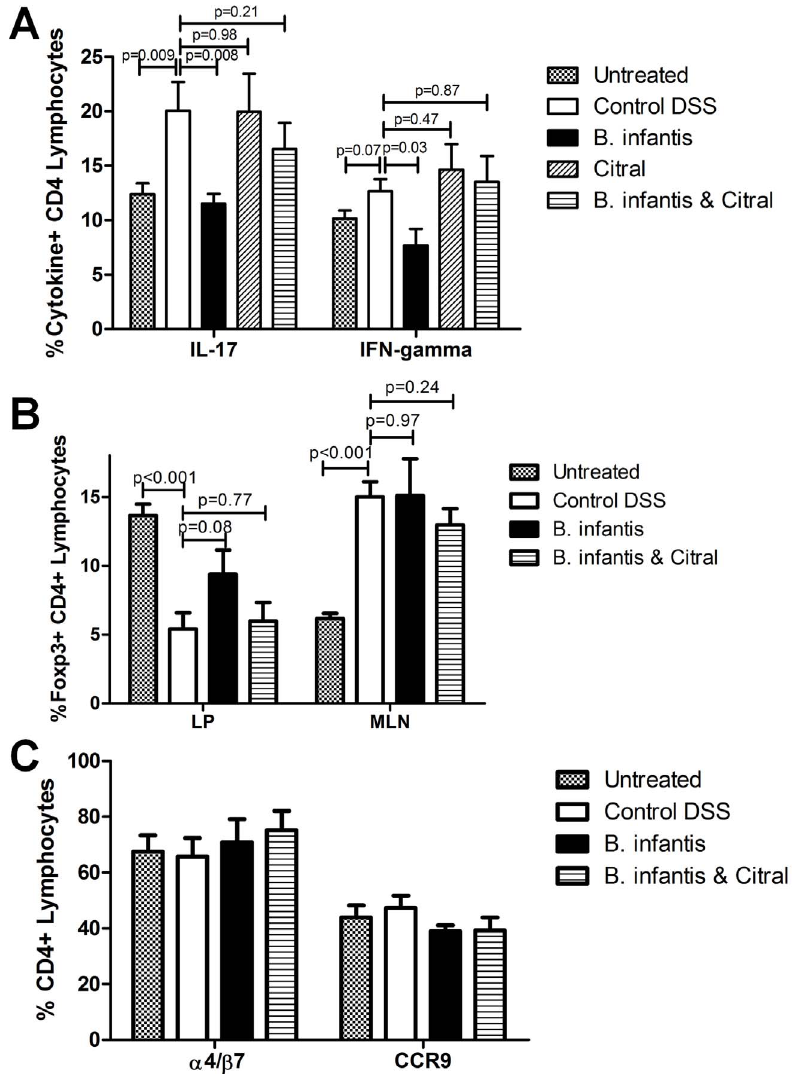
Figure 6. B.infantis alters T cell phenotypes within the inflamed LP. ( a ) DSS colitis increases the proportion of IL-17 + and IFN-gamma + CD4 T lymphocytes within the LP (n=8). However, B. infantis feeding (n=6) significantly reduces LP IL-17 + and IFN-gamma + subpopulations compared to DSS alone, which was inhibited by citral (n=7). Both subpopulations were similarly increased in DSS alone and DSS & citral (n=7). ( b ) CD4 + Foxp3 + lymphocytes were significantly increased in the MLN during DSS colitis (n=6), with a significant decrease of Foxp3 + lymphocytes being observed within the LP (n=6). B. infantis feeding (n=6) did not alter the increase in Foxp3 + cells in the MLN, but partially restored the deficit in Foxp3 + cells within the LP (n=6). ( c ) Expression of the gut homing receptors a 4 b 7 and CCR9 did not significantly change for any of the groups examined. Statistical significance was determined using unpaired student t-tests.